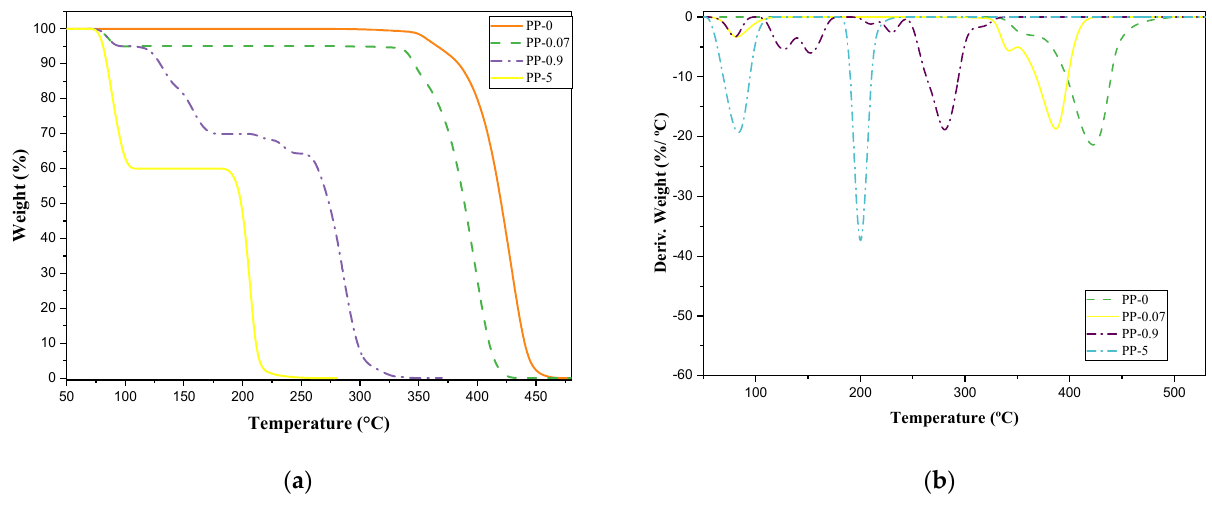
Figure 5. ( a ) TGA of the samples; ( b ) DTG of the samples.